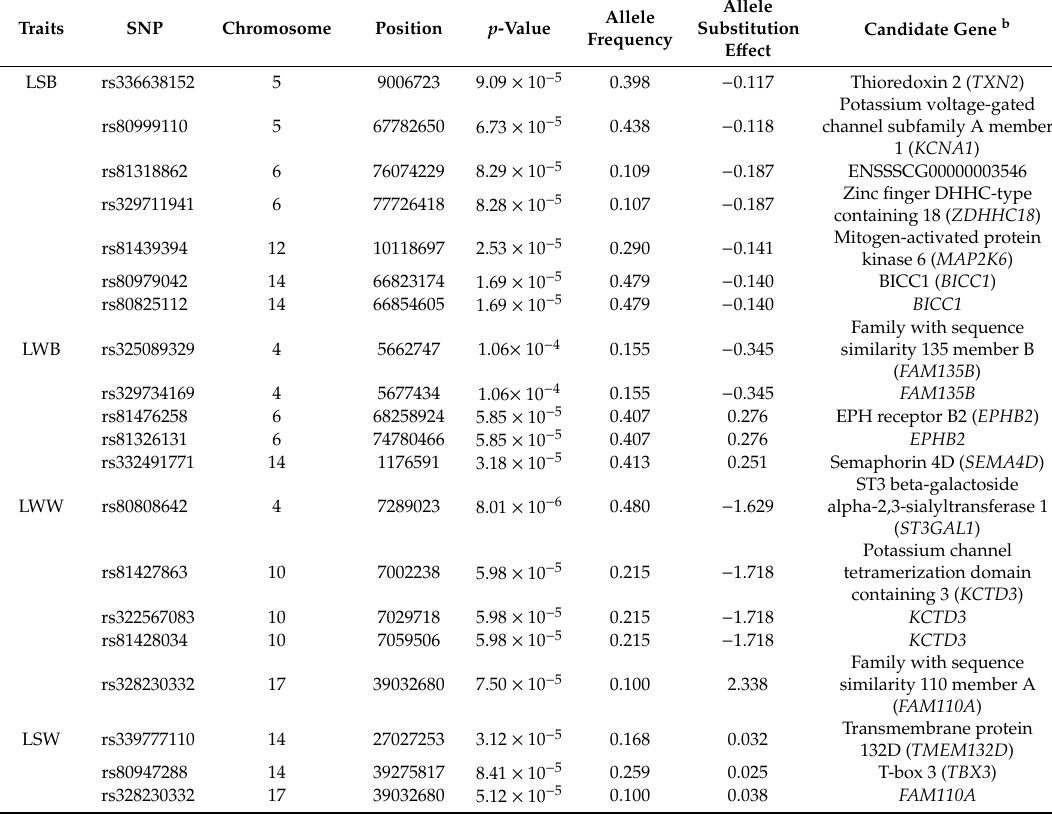
Table 3. Potential single-nucleotide polymorphisms (SNPs) and candidate genes detected in the genome-wide association study for four porcine reproduction traits.